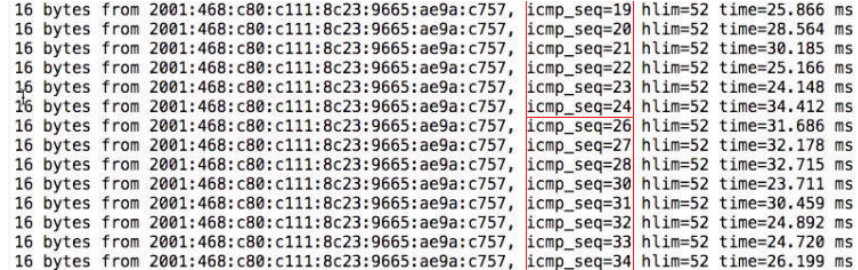
Figure 5: ICMP pingflood traffic from simulated attacker on a remote Internet connection at 50 ms interval.